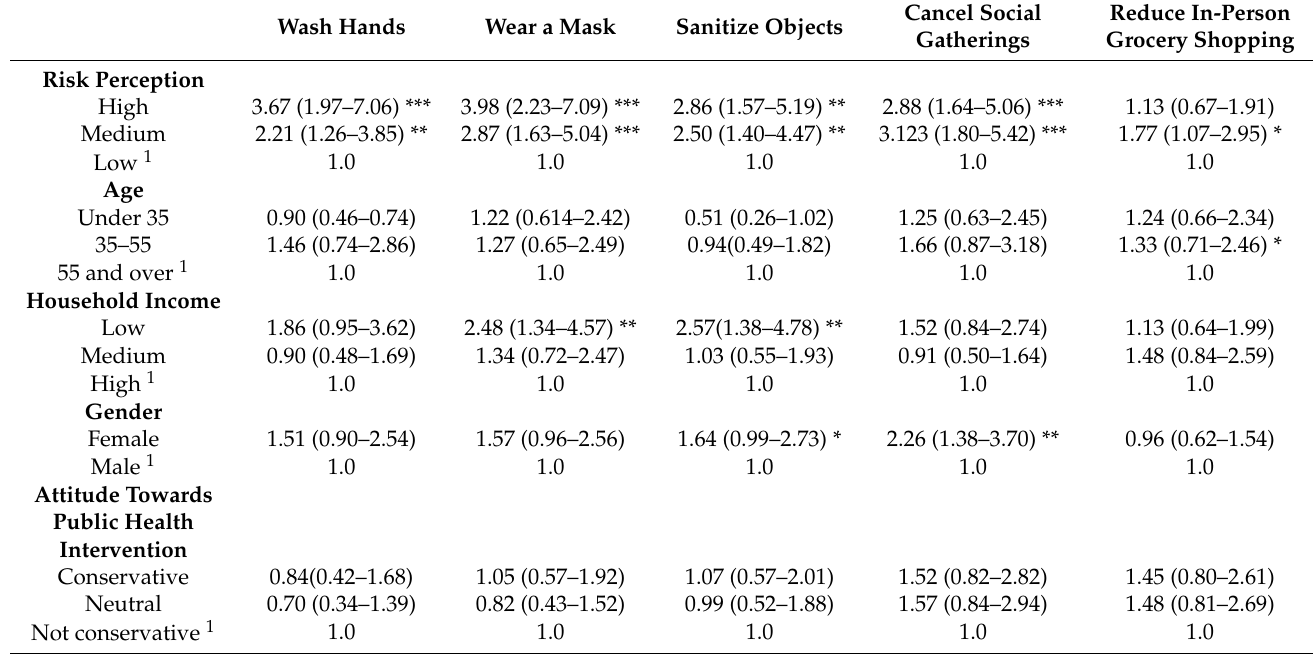
Table 3. Logistic regression analysis assessing the factors associated with each prevention practice in February (early stage): odds ratio and 95% confidence interval.